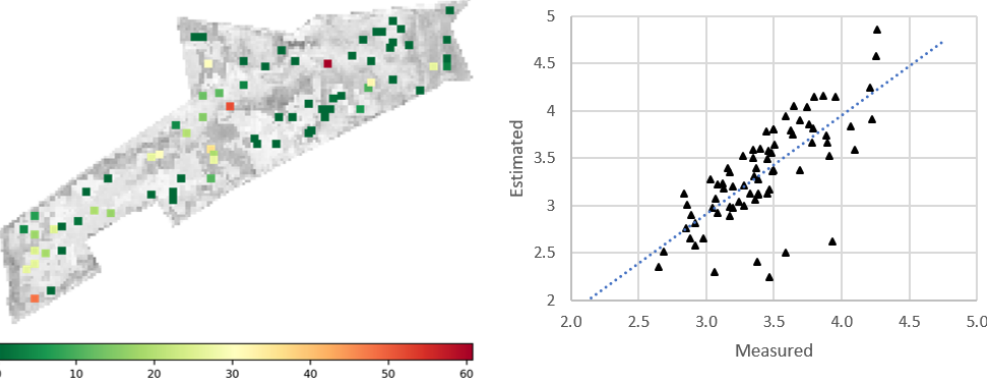
Figure 9. Validation of SOM value prediction model with its error as a map and scatter plot on Stadtfeld field [46] from the second sampling